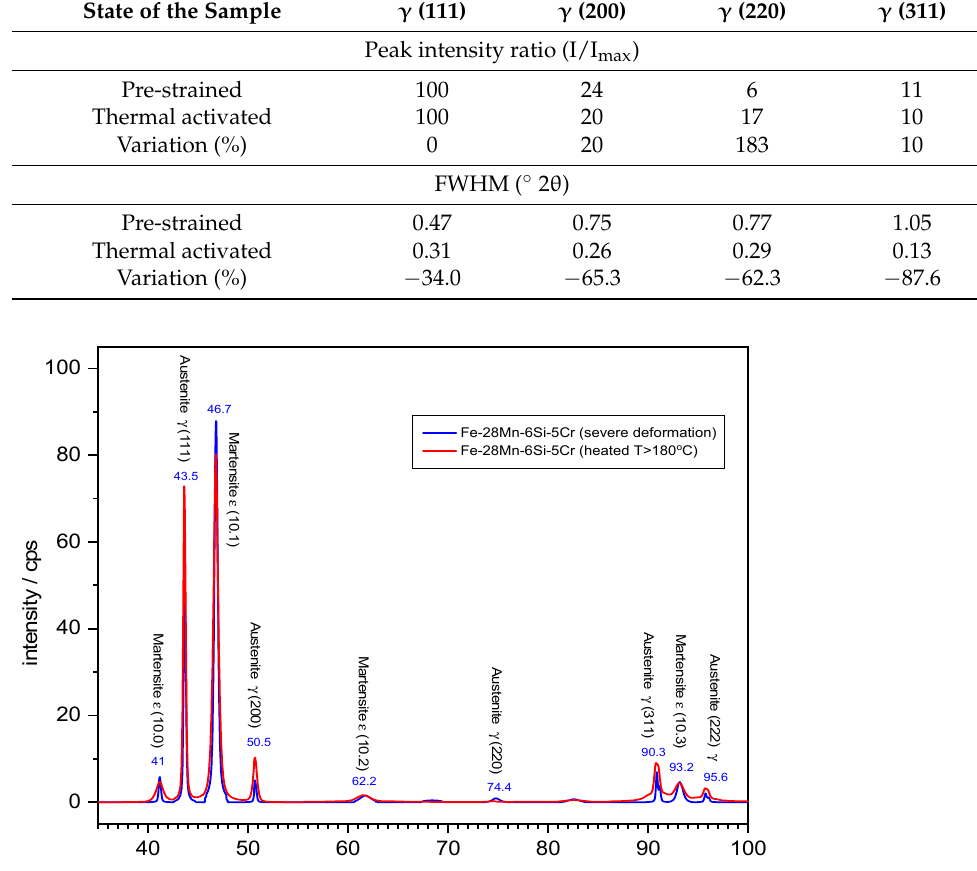
Table 2. Peak intensity ratio (I/I max ) and FWHM corresponding to the characteristic diffraction peaks of the γ -austenite.